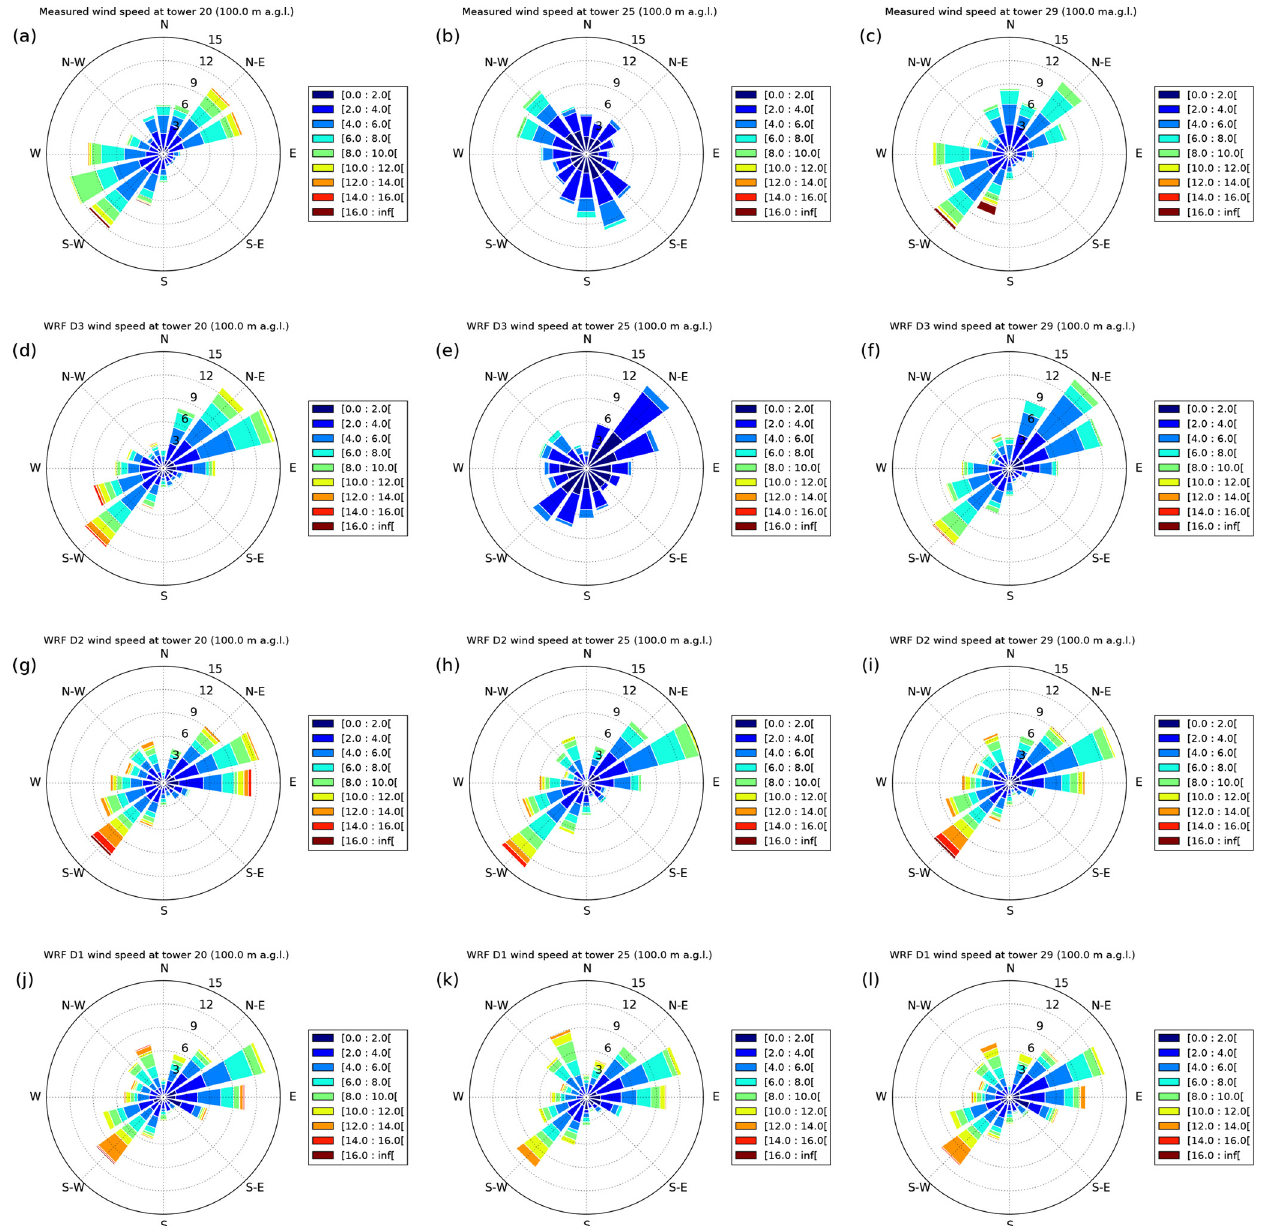
Figure 7. Wind distribution at 100ma.g.l. for observed (a–c) and simulated horizontal winds for (d–f) domain D3, (g–i) domain D2 and (j–l) domain D1. The columns from the left to the right correspond to the locations of towers T20, T25 and T29, respectively (see Fig. 1c for tower